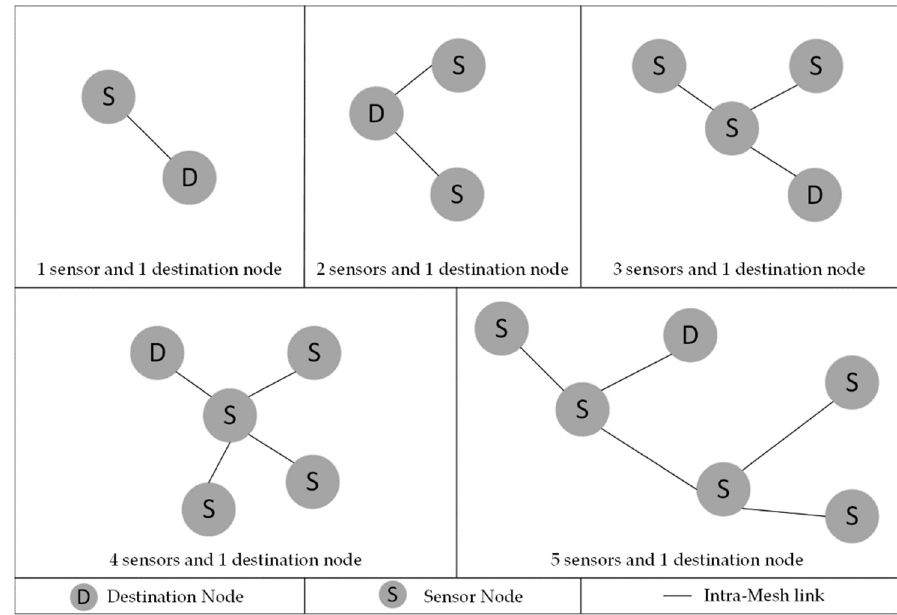
Figure 9. Number of sensor and destination nodes.